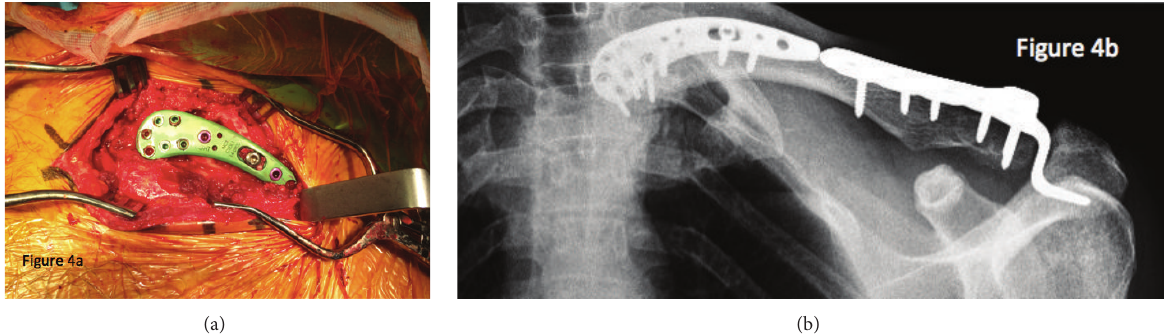
Figure 4: (a) Intraoperative photograph depicting the medial clavicular fixation. (b) Final fixation construct with both medial and lateral plates after healing had